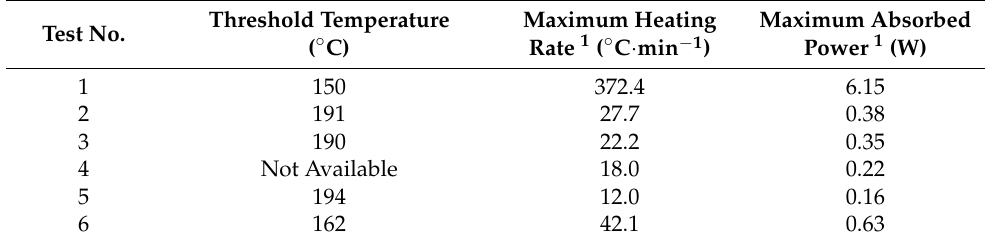
Table 4. Threshold temperature for microwave-assisted devulcanization, maximum heating rate, and sensible absorbed power.